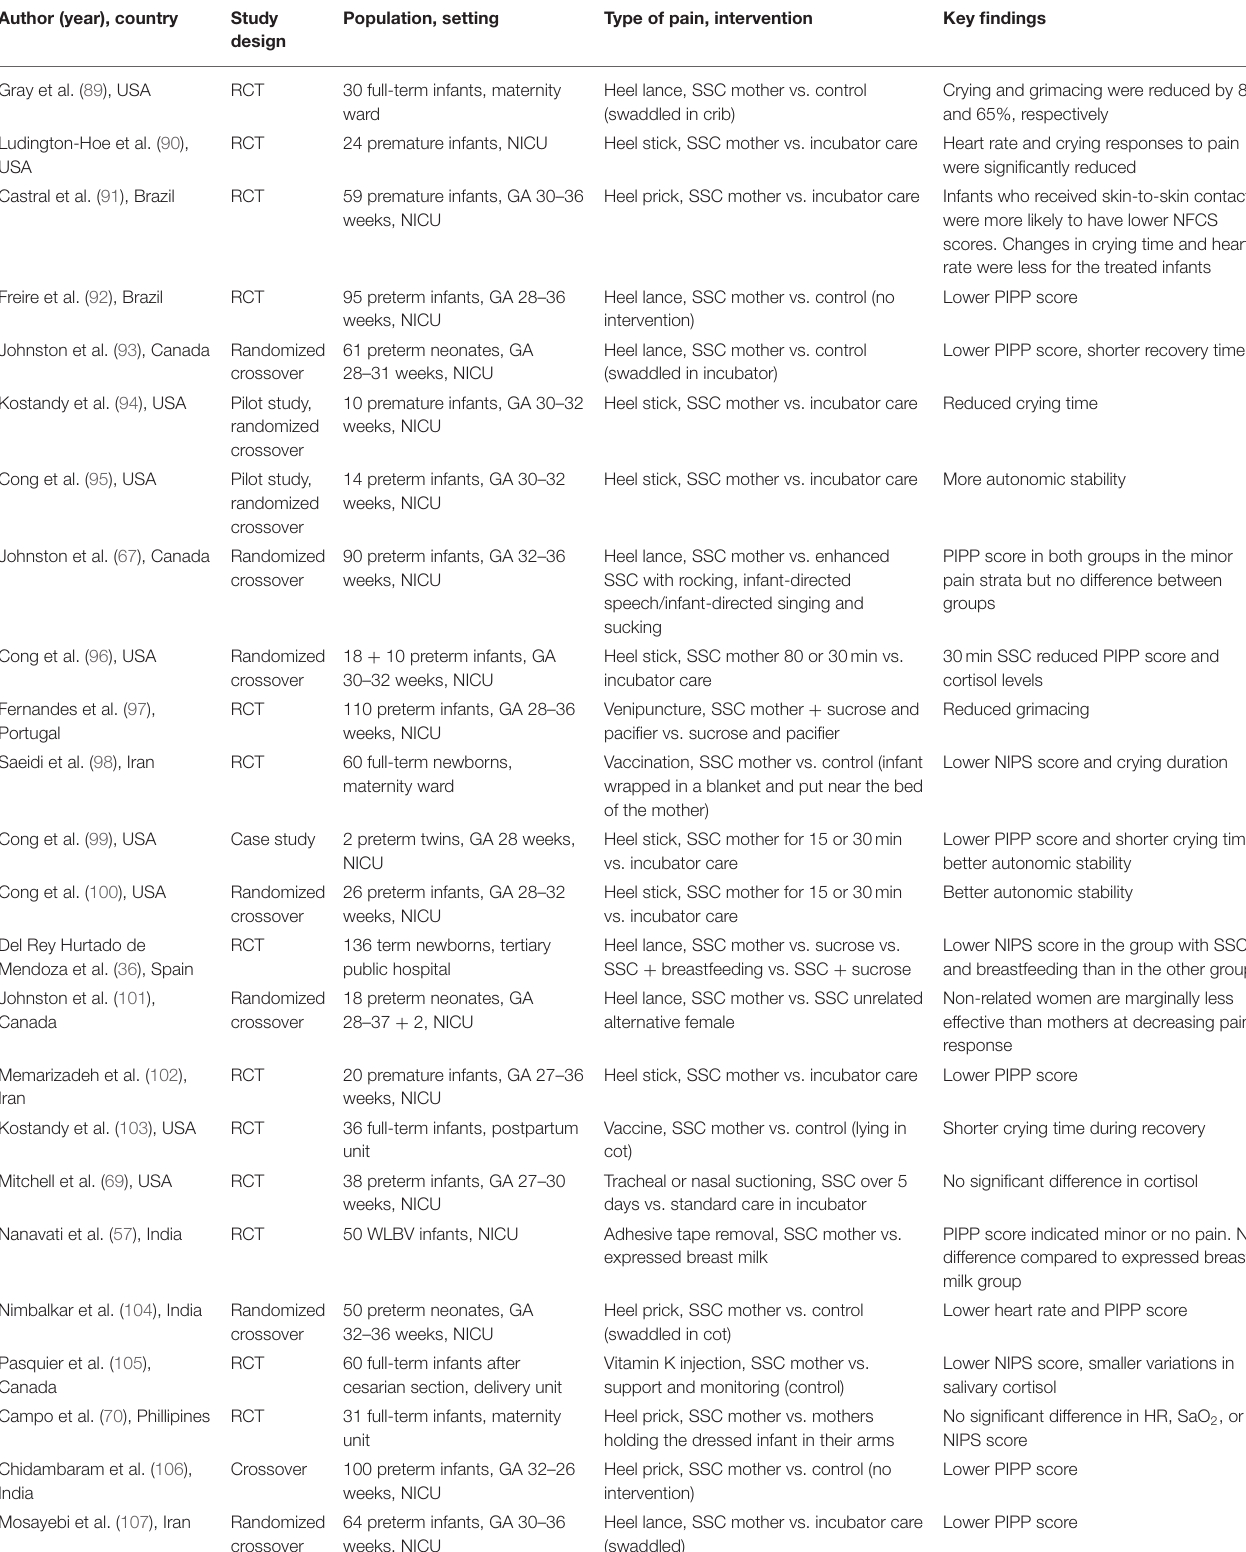
TABLE 7 | Evidence for parent-delivered interventions: skin-to-skin